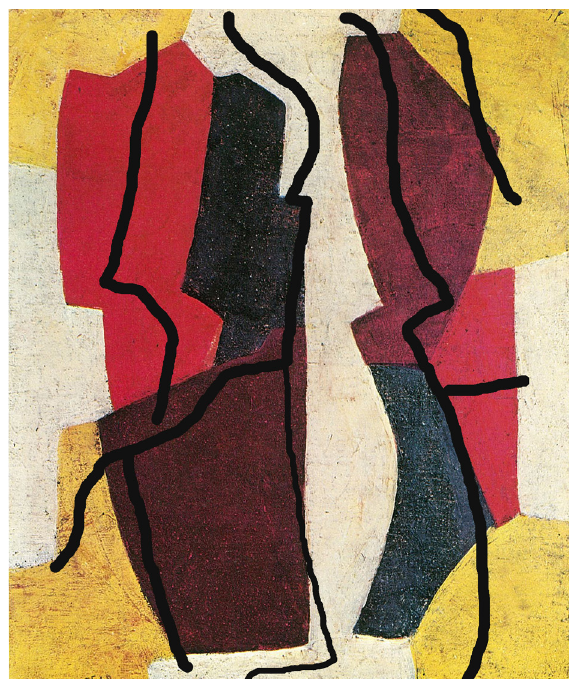
FIGURE 6 | ‘Composition 1969’ by Poliakoff.